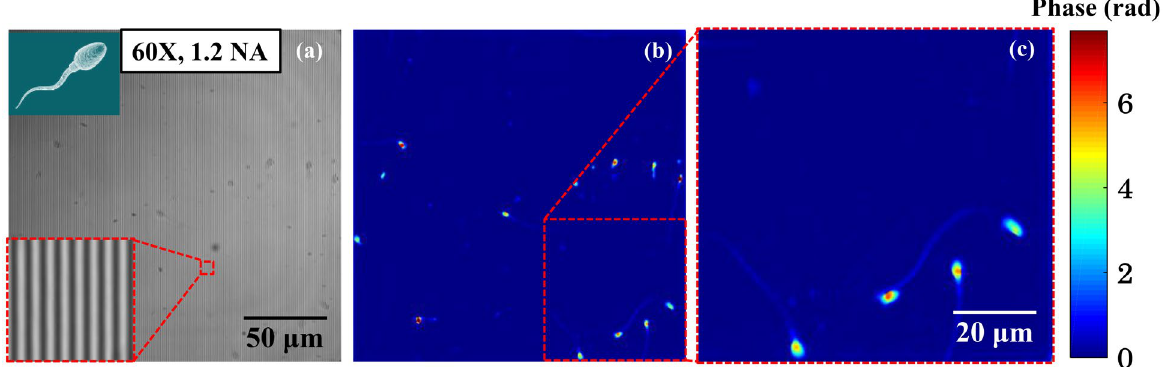
Figure 6. PTLS provides high resolution video rate phase images of fast moving transparent biological cells. A water immersion objective lens with 60 × /1.2 NA is used to image fast moving human sperm cells. ( a ) Interferometric image of live human sperm cells (see Visualization 1). The inset depicts the zoomed view of the region marked with red dotted box. ( b ) Reconstructed high-resolution phase image of the sperm cells (Visualization 2). ( c ) The zoomed view of the phase image of sperm cells enclosed by red dotted box shown in ( b ). The scale bars are in micron. The color bar is in